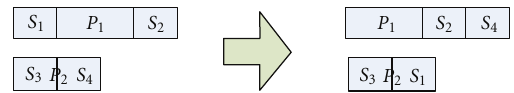
Figure 1: Elongation and truncation operation of DNA subsequences.